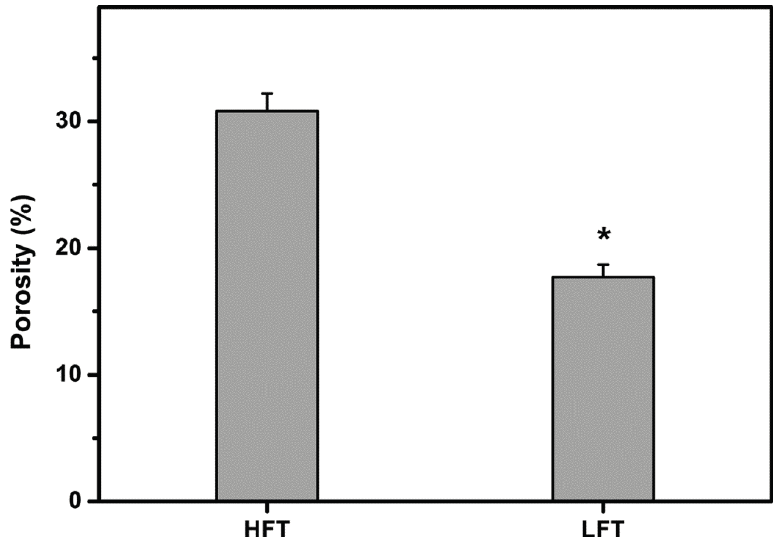
Figure 3. Porosity of various HA carriers. An asterisk indicates statistically-significant differences ( * p < 0.05; n = 4) as compared to the HFT